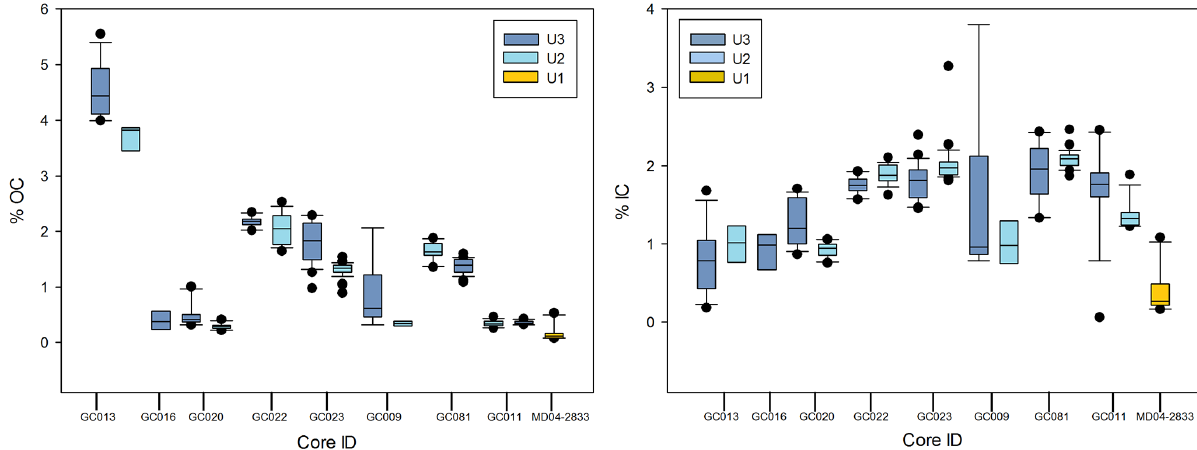
Figure 5. %OC and %IC values from each sediment cores corresponding to seismic units 1, 2 and 3.